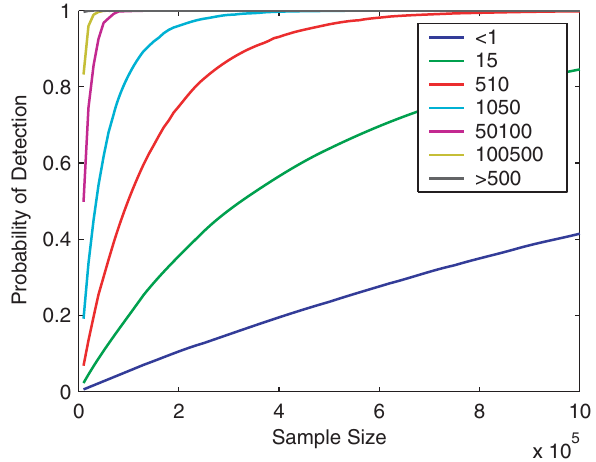
Figure 5. Detecting probabilities in different expression level bins at different sampling stages. Monte Carlo simulation is done with the fitted RAD and estimated transcriptome diversity S of the pooled library. Assuming there are 1,000,000 copies of transcript per cell, the detecting probabilities of transcripts in different expression level bins are plotted as a function of sample size N .